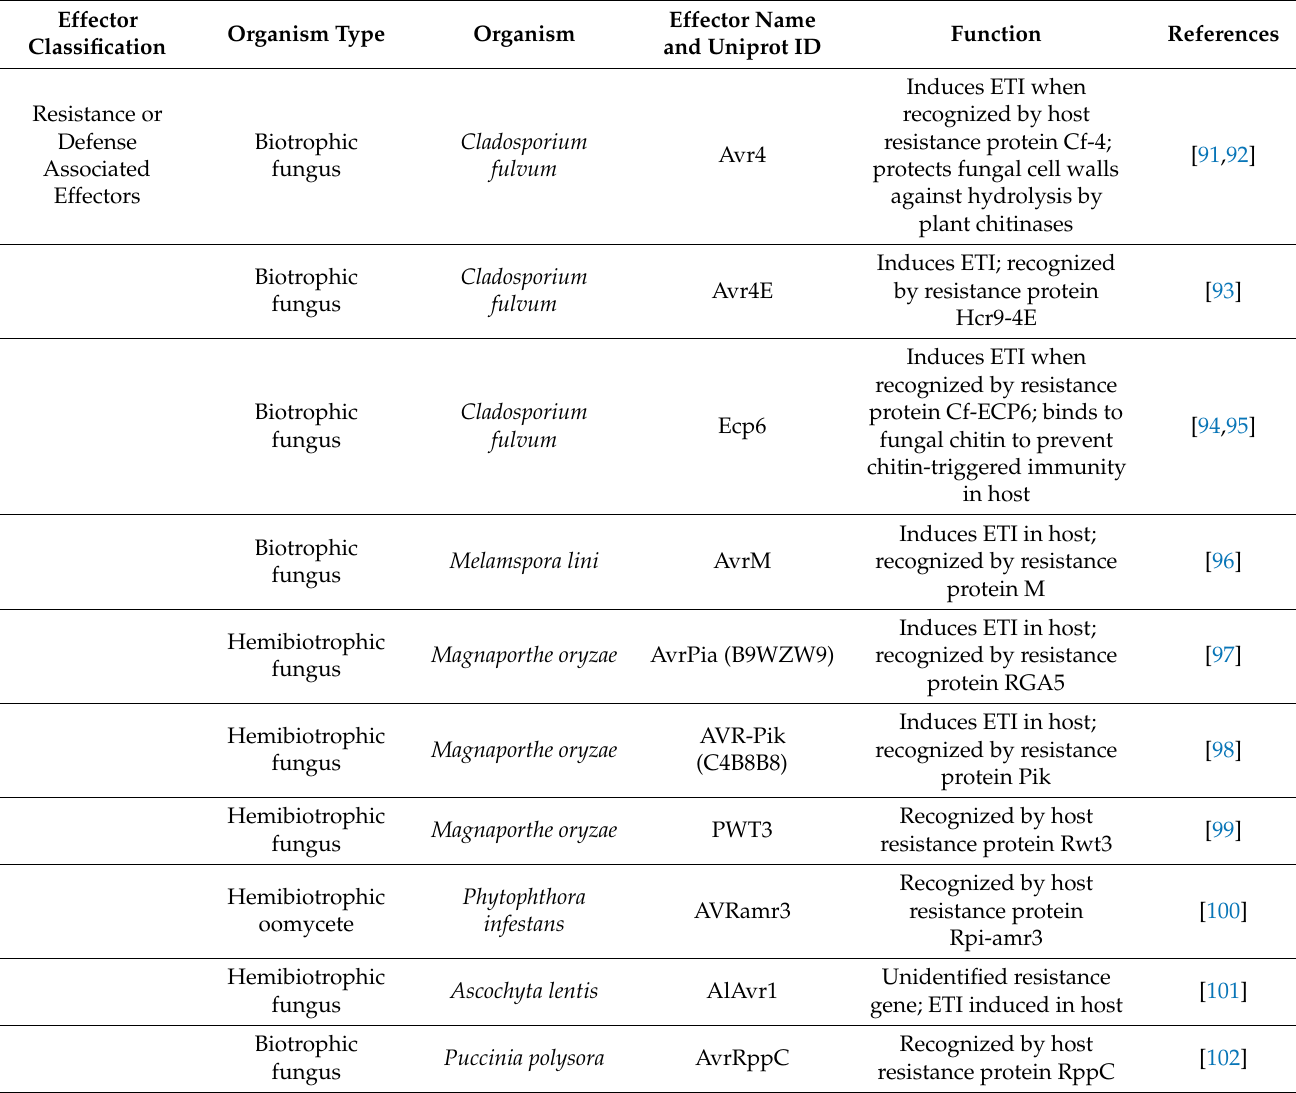
Table 1. Examples of characterized effectors of biotrophic, necrotrophic and hemibiotrophic fungal and oomycete pathogens that are associated with disease resistance and disease